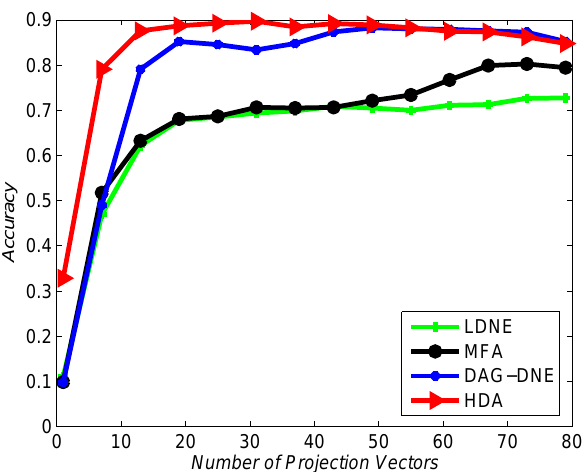
Figure 7. Accuracy vs. Number of Projection Vectors on the UMIST dataset under K = 1.